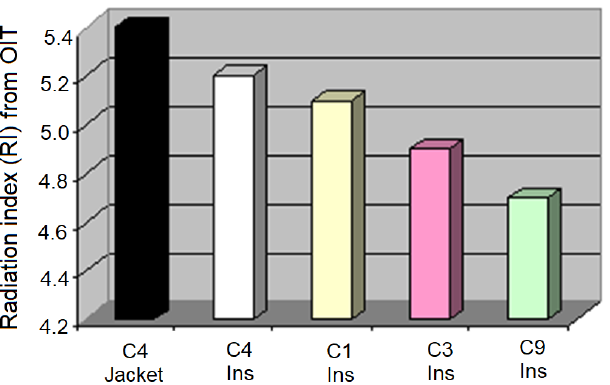
Figure 6. RI values of irradiated LDPE cable materials (strap, γ 137 Cs, D r = 0.4 kGy/h); C9 was irradiated as bulk (free ends).